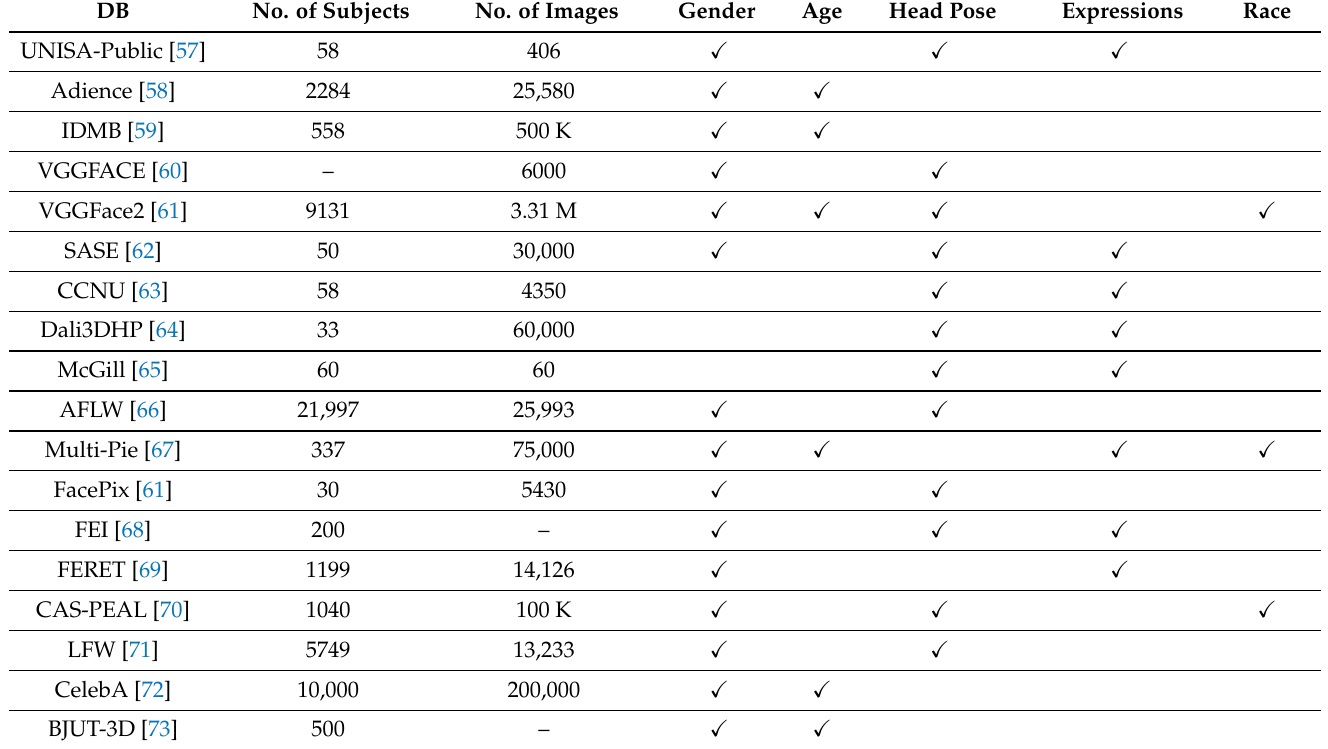
Table 1. Publicly available DBs for gender, age, head pose, expression, and race